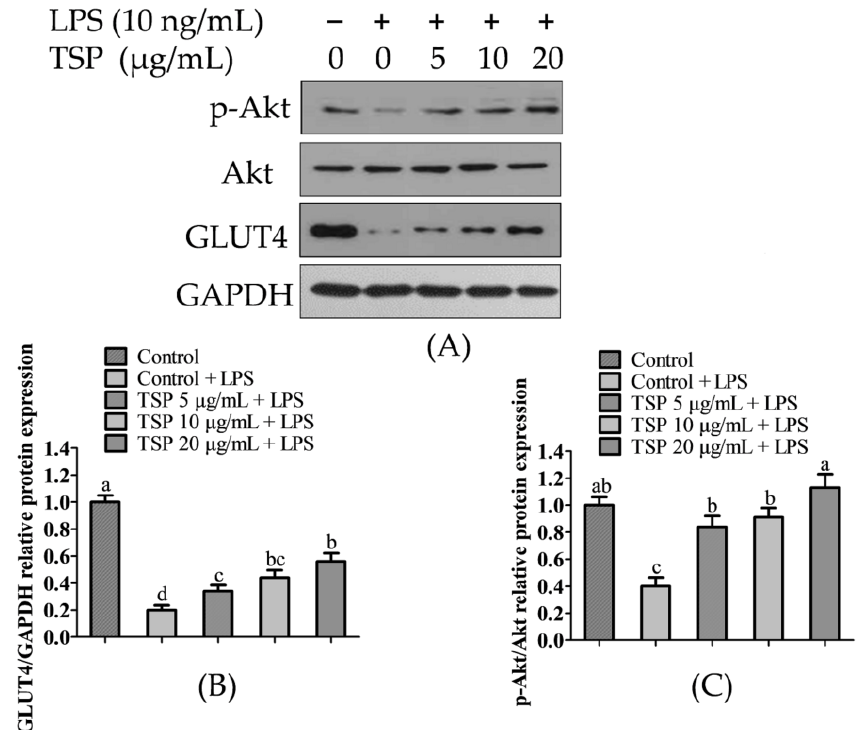
Figure 3. TSP can alleviate the inflammatory-induced insulin resistance of adipocytes. ( A ) The expression of p-Akt, Akt , and GLUT4 proteins was tested by western blotting. ( B ) GLUT4/GAPDH relative protein expression. ( C ) p-Akt/Akt relative protein expression. Data are presented as mean ± SD (n = 3); Results marked with the same letters were not significantly different ( p < 0.05).